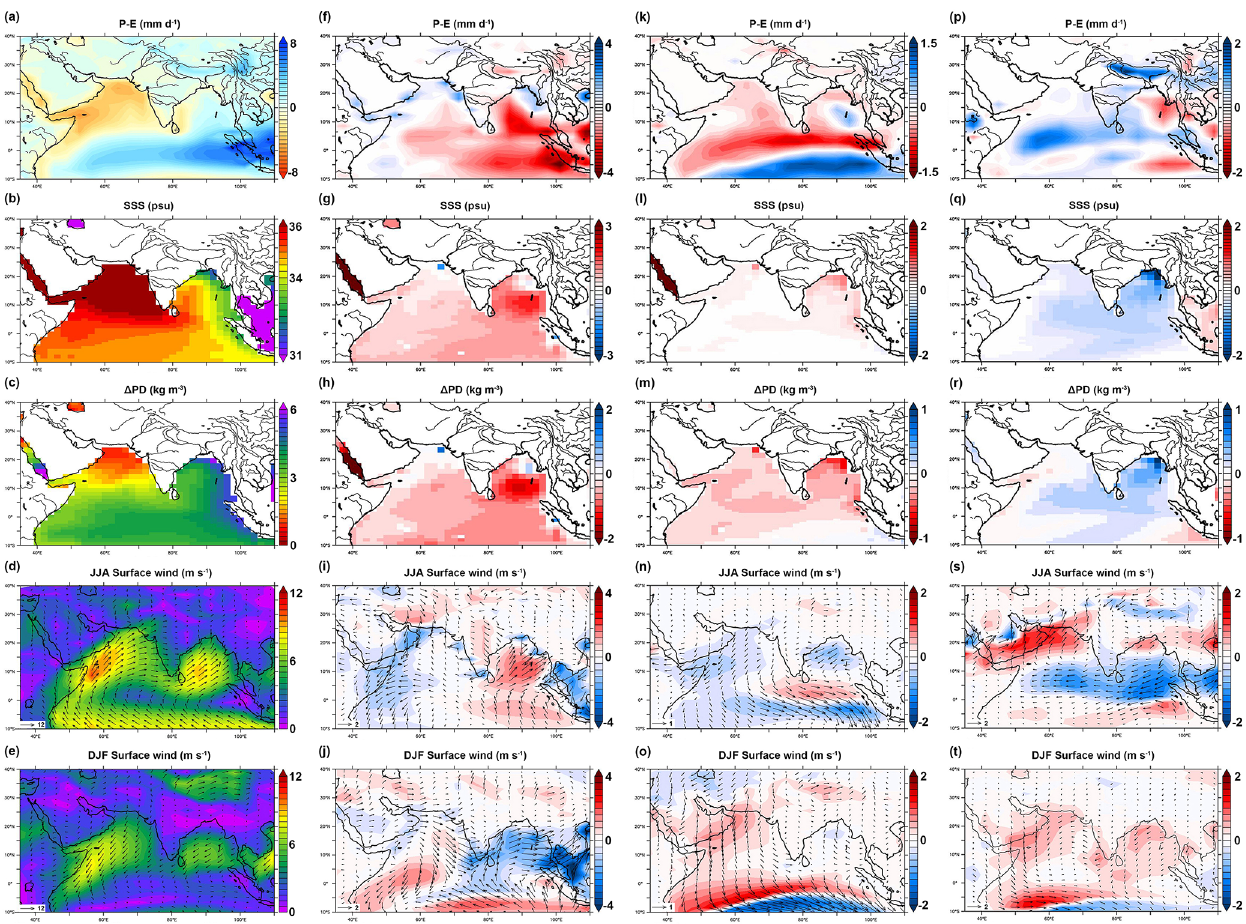
Figure 7. IPSL-CM5A-LR outputs. (a–e) Results of CTRL. (f–j) Differences between LGMc and CTRL. (k–o) Differences between LGMf and LGMc. (p–t) Differences between MH and CTRL. The parameters are annual mean precipitation minus evaporation ( P − E , net pre- cipitation), sea surface salinity (SSS), potential density gradient between 200 and 5m (stratification of the upper seawater; Behrenfeld et al., 2006), and summer (June–July–August, JJA) and winter (December–January–February, DJF) surface wind speed and vectors. These figures give the results of simulated changes in climate and oceanic conditions over South Asia and the northern Indian Ocean. Stronger net precipitation is marked by blue, higher SSS is marked by red, stronger stratification is marked by blue, and stronger surface wind is marked by